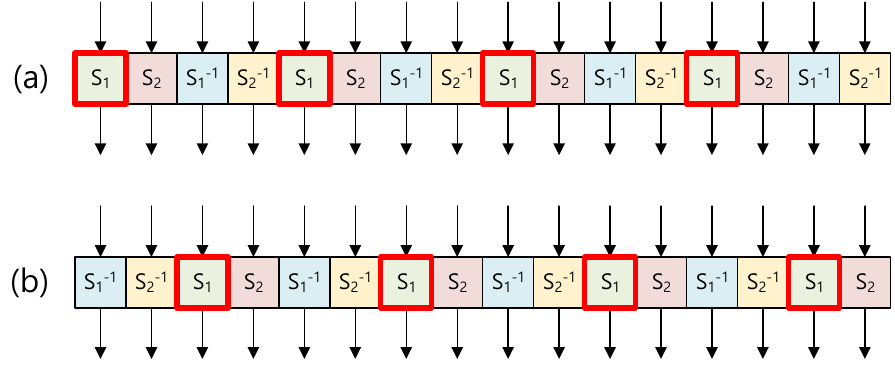
Figure 2. Substitute layer ( a ) type 1 and ( b ) type 2 in a grouped way.